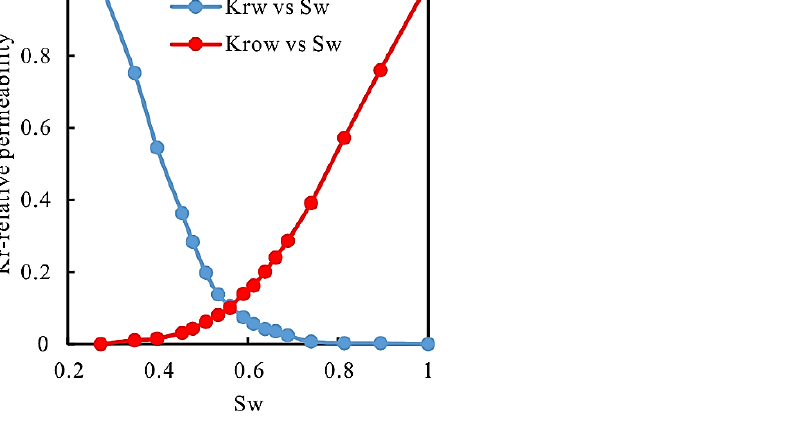
Figure 9. Oil-water relative permeability curve.